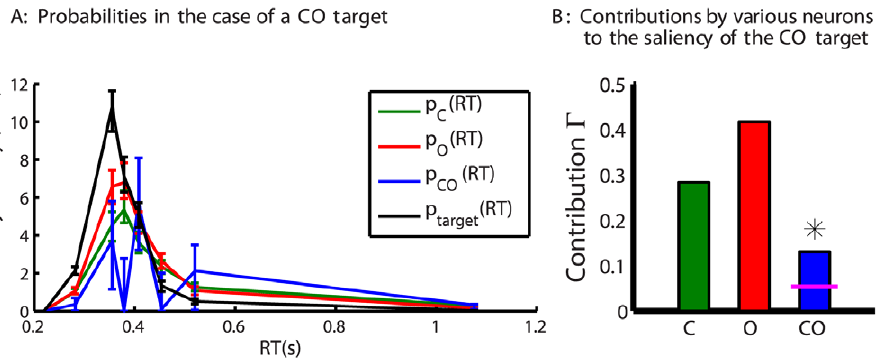
Figure 6. The results for the CO target from a typical subject. A: probability densities for RT C , RT O , RT CO , and RT target . Each density function is plotted as piece-wise lines linking discrete points, with the i th point at RT ~ ( t i z t i { 1 ) = 2 horizontally and p i = ( t i { t i { 1 ) vertically, where p i is the probability that the corresponding RT is in the i th time bin ( t i { 1 ƒ RT v t i ). All curves start at p 0 ~ 0 at t 0 . For RT C , RT O , and RT target , the probability n j ) , where n i is the number of RT samples in the i th time bin for the corresponding target. For RT CO , p i is from the outcome of the p i ~ n i = ( P j optimization. The error bars are generated as follows. For each target type, let RT 1 v RT 2 v ::: RT a v ::: v RT M be all the behavioral RT samples included, and let the cumulative RT distribution cdf ( RT ) for this target be approximated by a function which has piece-wise interpolations between discrete functional values cdf ( RT ~ RT a ) ~ ( a { 0 : 5) = M and has cdf ( RT v RT 1 ) ~ 0 and cdf ( RT w RT M ) ~ 1 . Randomly generate M simulated RT samples using this cdf ( RT ) . Using these simulated RT samples (as if they were the original RT data) for all target types, we obtain another measurement of the probability densities for all target types and, via our optimization method, all neuron types. Repeat such measurements 500 times. Each error bar has its lower and higher values at the 16 th and 84 th percentiles, respectively, of the corresponding density measurements. B: Contributions C C , C O , and C CO of the C, O, and CO neurons, respectively, to the saliency of the CO double feature target for this subject. Each contribution is the probability that the corresponding neuron dictates the saliency of the CO target (by giving the highest response among responses from all three types of neurons to the CO target). In obtaining their values, probabilities of RT C and RT O from optimization outcomes, rather than behavioral data, were used. The ‘*’ on top of C CO indicates that C CO is significantly different from C chance whose mean value is marked by the magenta line.